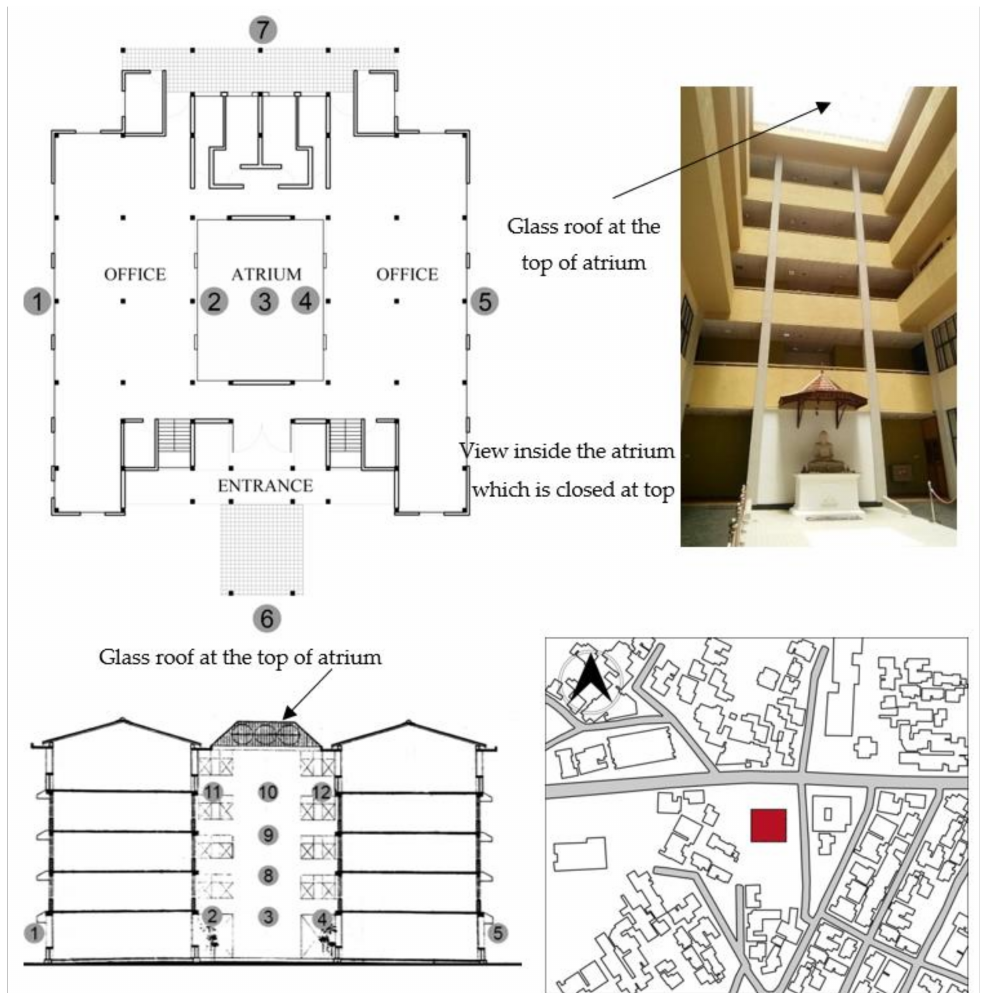
Figure 9. Building C (plan depth—25 m, length—26 m) Top left—Atrium plan form, Top right—Building in semi dense urban context, Bottom left—Section through the building with a central atrium.